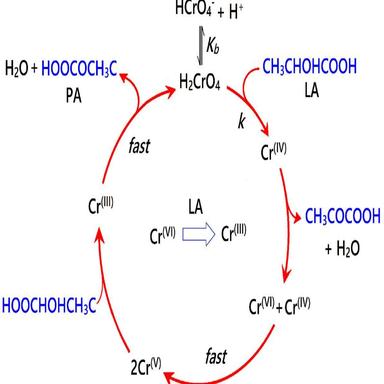
The possible kinetics and mechanism pathway of the reduction of Cr(VI) using LA in an acidic medium.